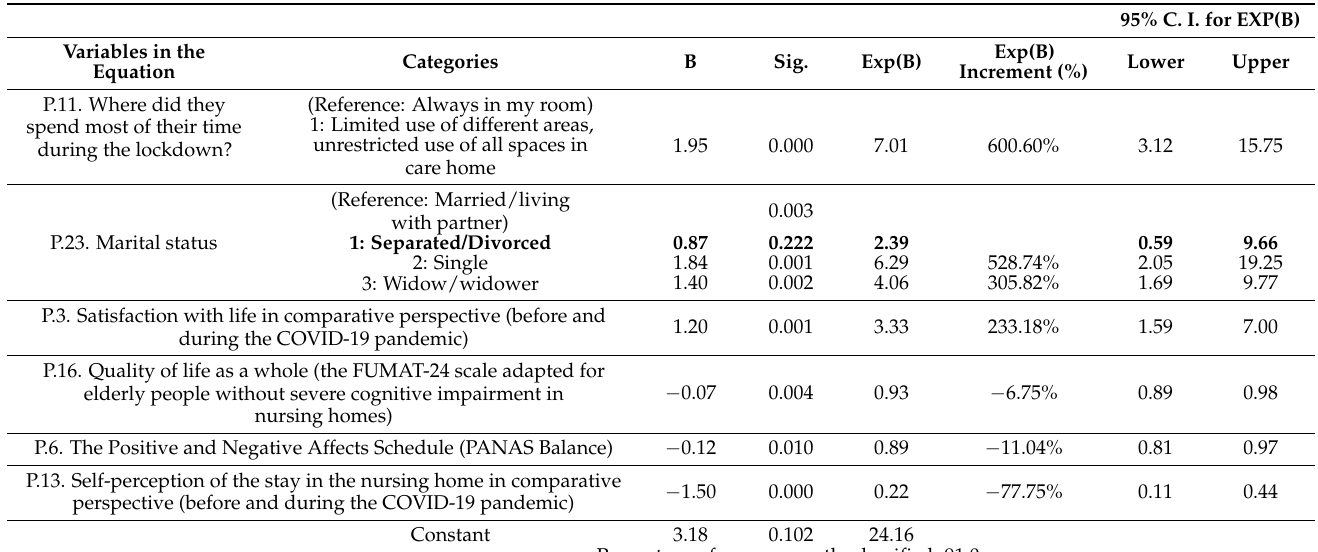
Table 4. Logistic regression model for residential assessment cluster 3: Low rating for all aspects of the residential